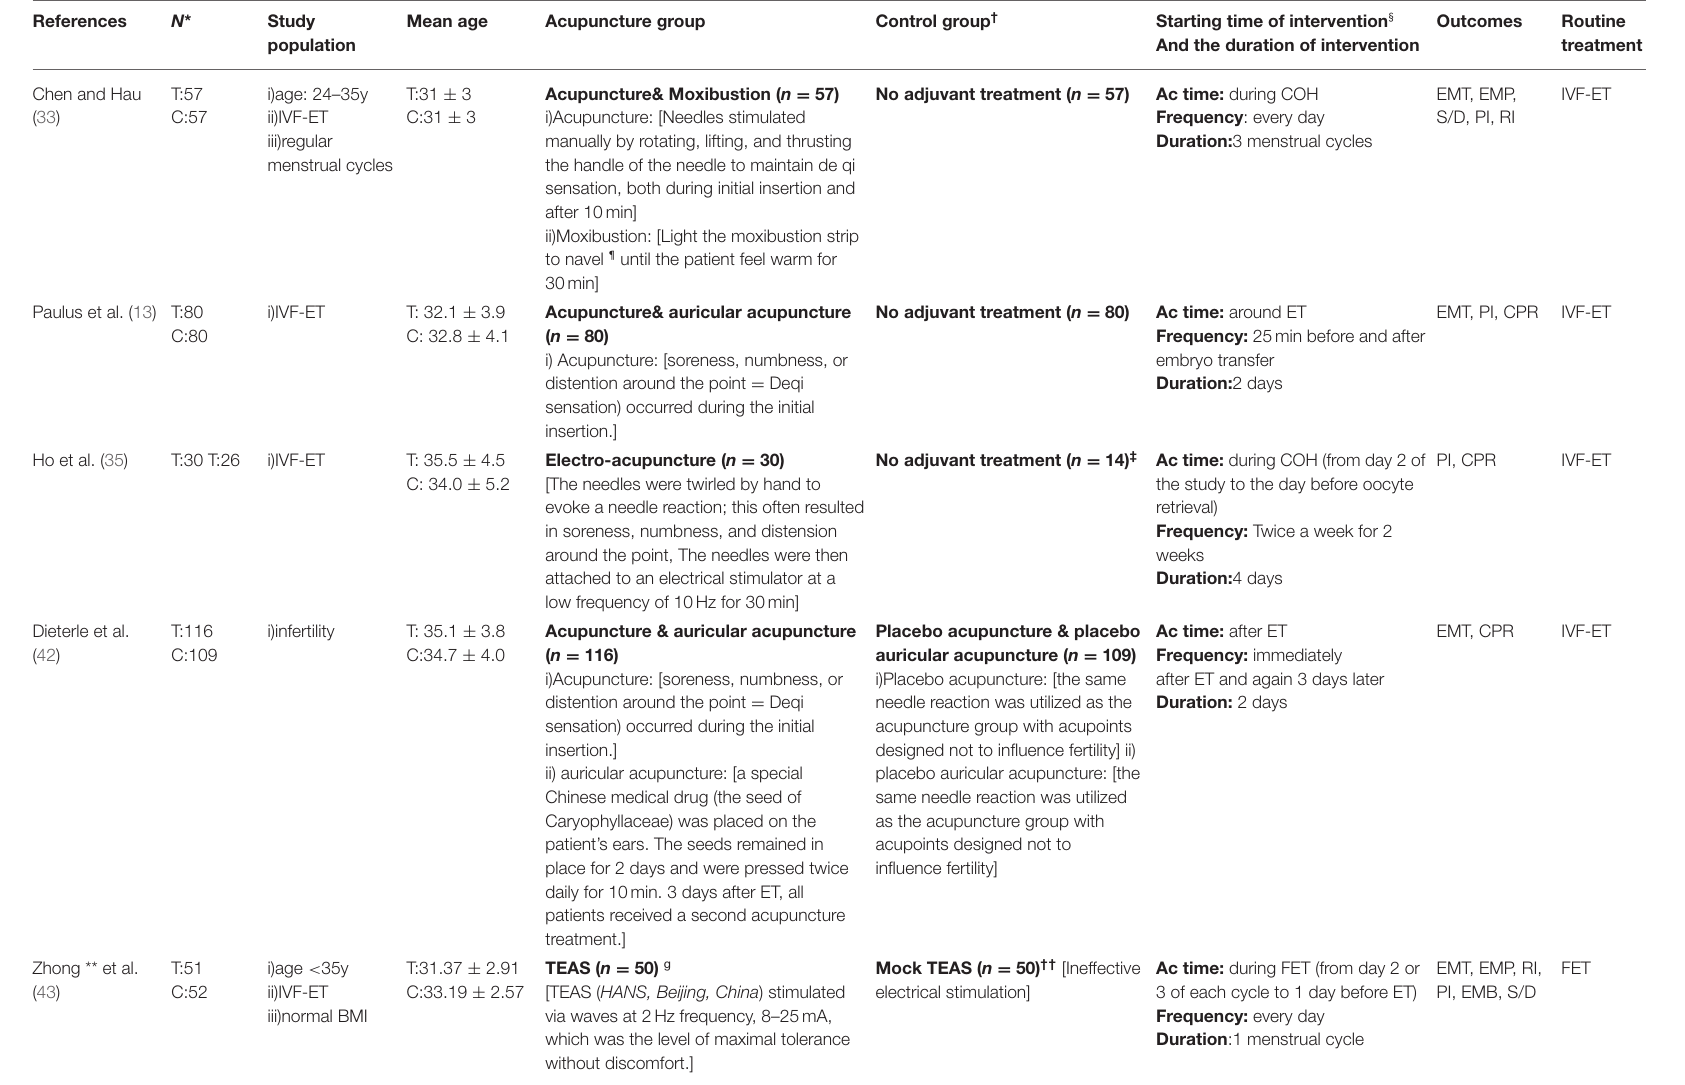
TABLE 1 | Characteristics of included